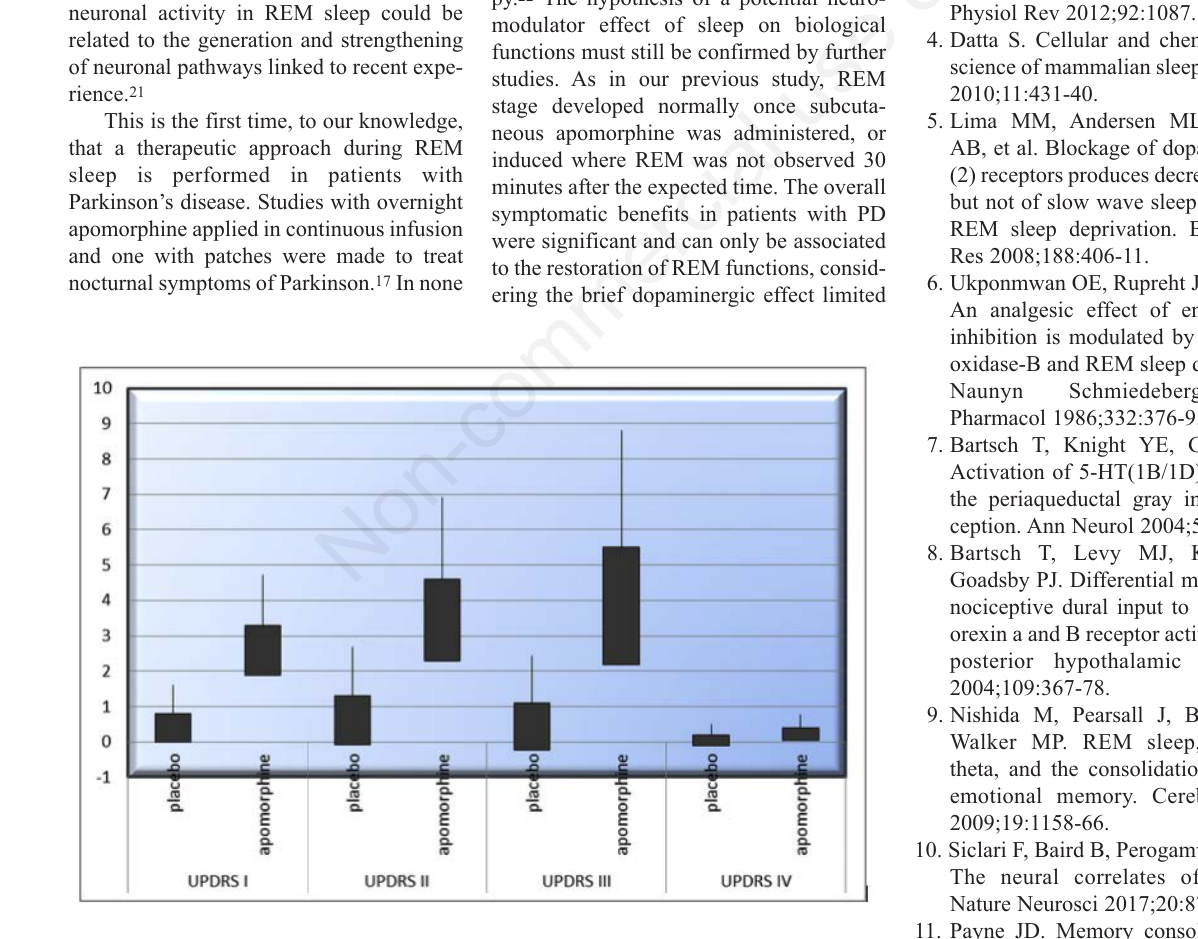
Figure 4. Comparative study between placebo and apomorphine groups. UPDRS Part I total score of 0.8 (95% CI: 1.612, -0.012) and 3.3 (95% CI: 4.732, 1.867), respectively. UPDRS Part II: mean change of 1.3 (95% CI: 2.692, -0.09) and 4.6 (6.916, 2.28). UPDRS Part III of 1.1 (95% CI: 2.425, -0.225) and 5.5 (95% CI: 8.808, 2.191). UPDRS Part VI of 0,2 (95% CI: 0.501, -0,101) and 0,4 (95% CI: 0.769, 0.03),